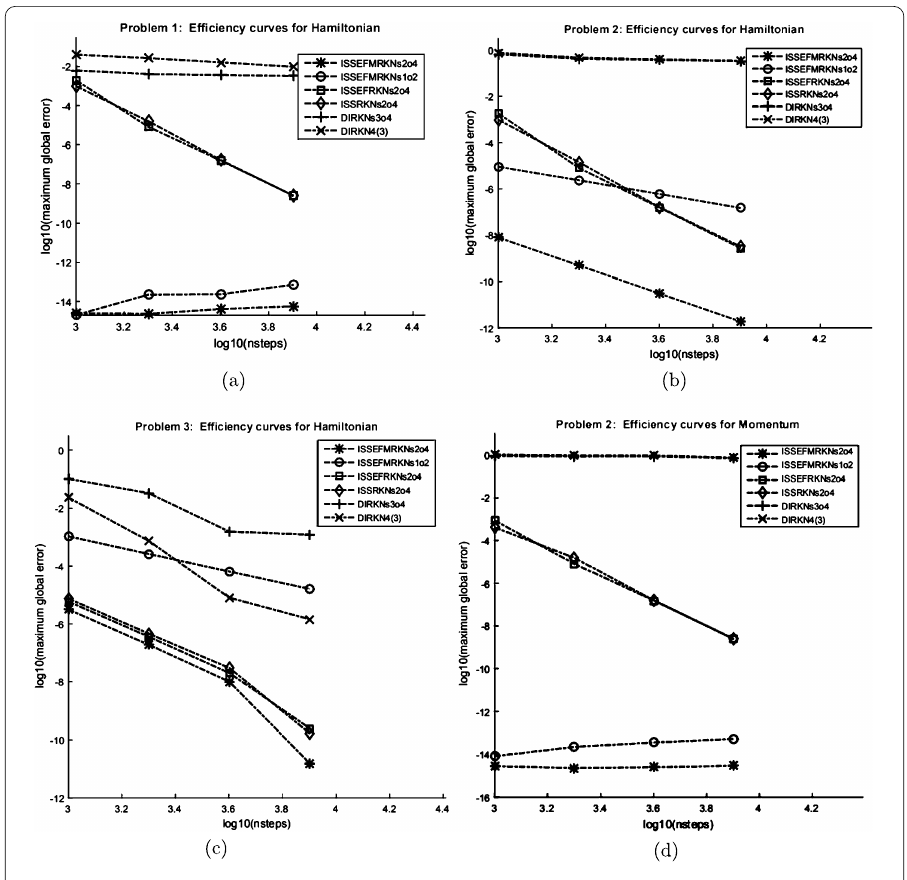
Figure 2 Efficiency curve for Hamiltonian in ( a ) Problem 1, ( b ) Problem 2, ( c ) Problem 3 and for momentum accuracy comparison in ( d ) Problem